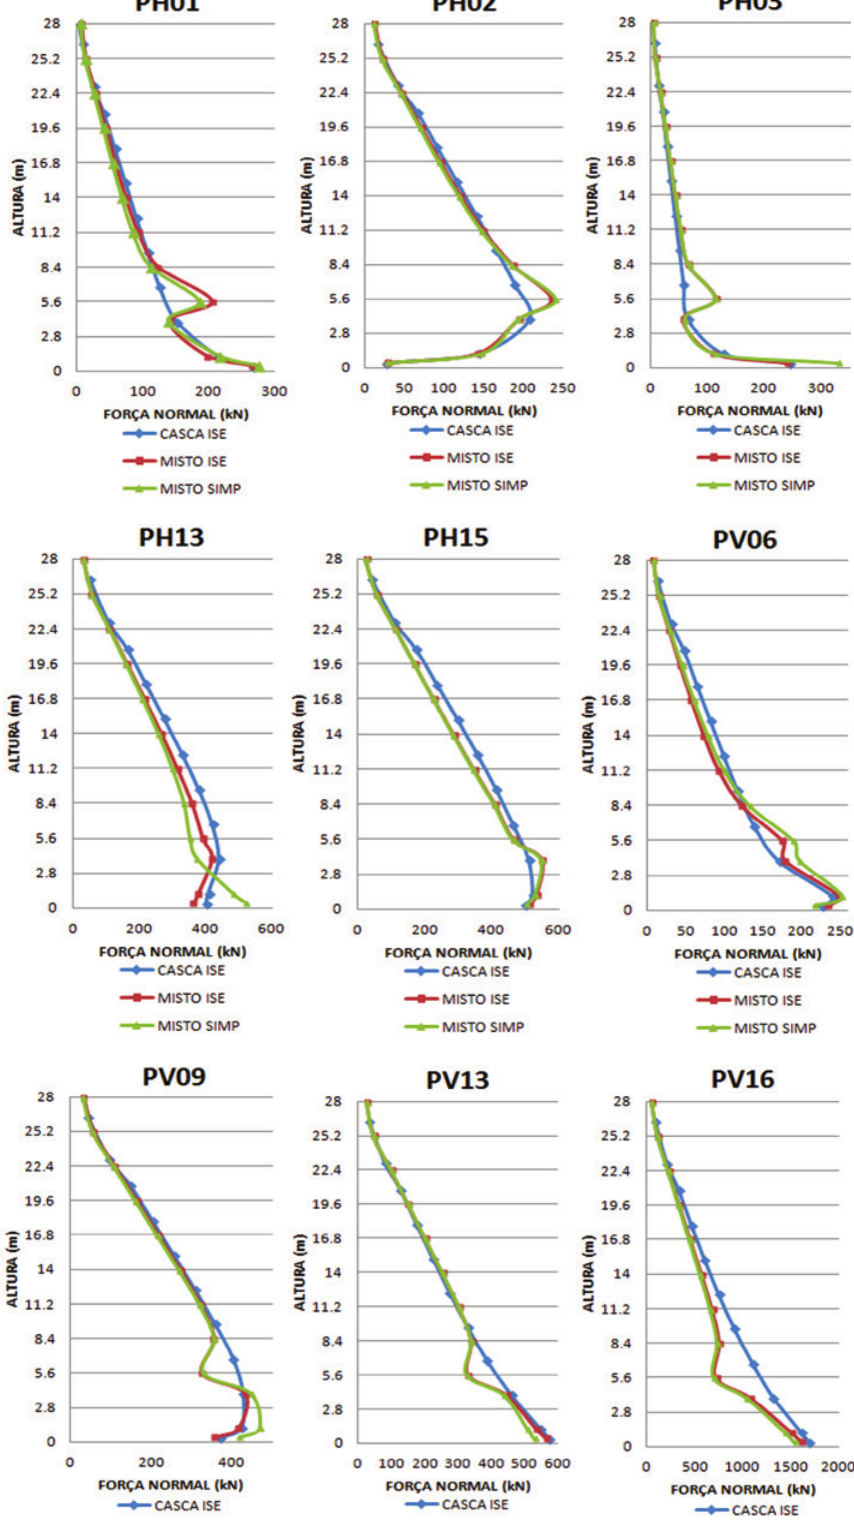
Figura 14 Diagrama de força normal das paredes dos modelos